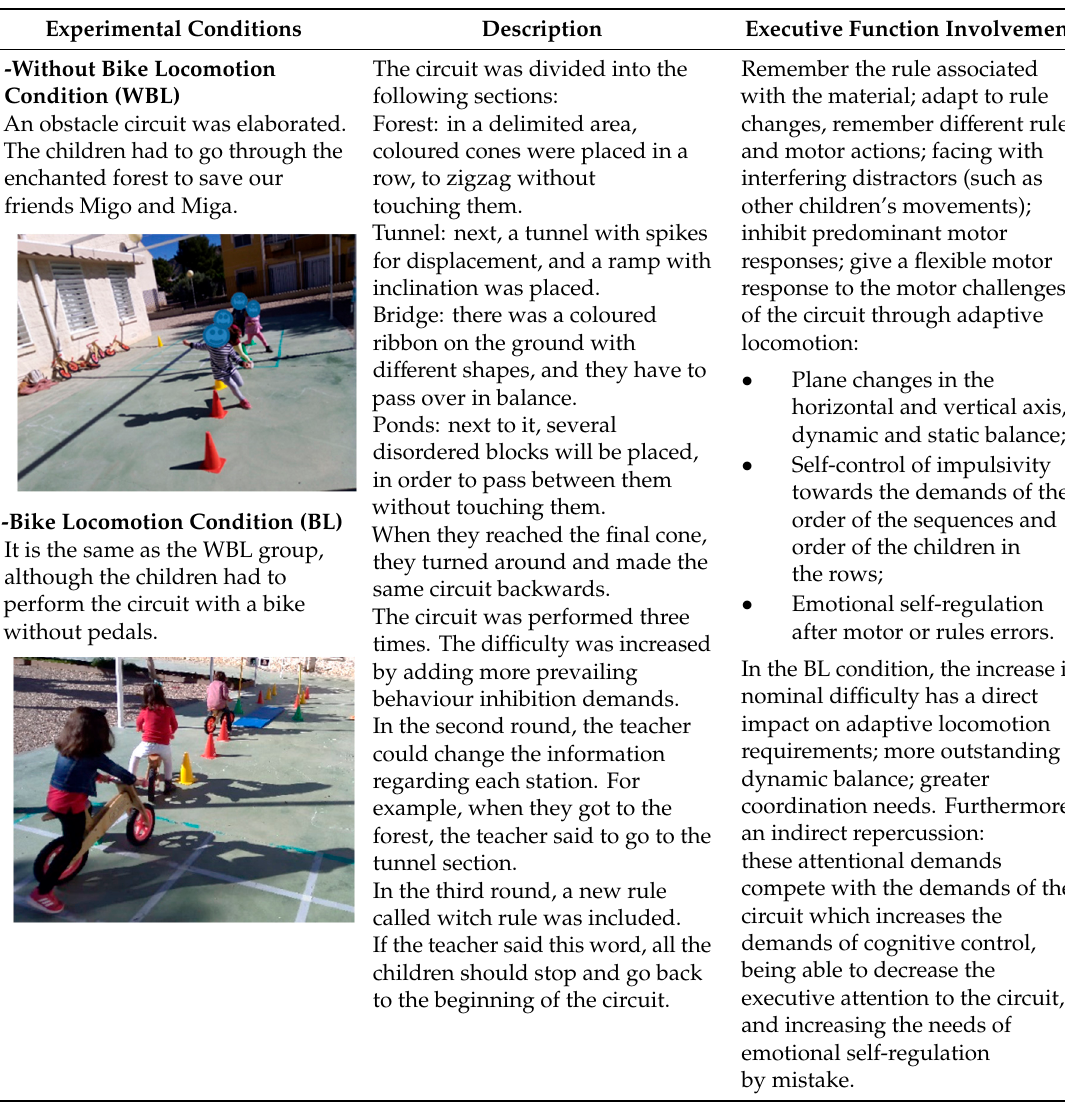
Figure 1. Procedure of the study. Table 1. Description of experimental conditions. Table 1. Description of experimental